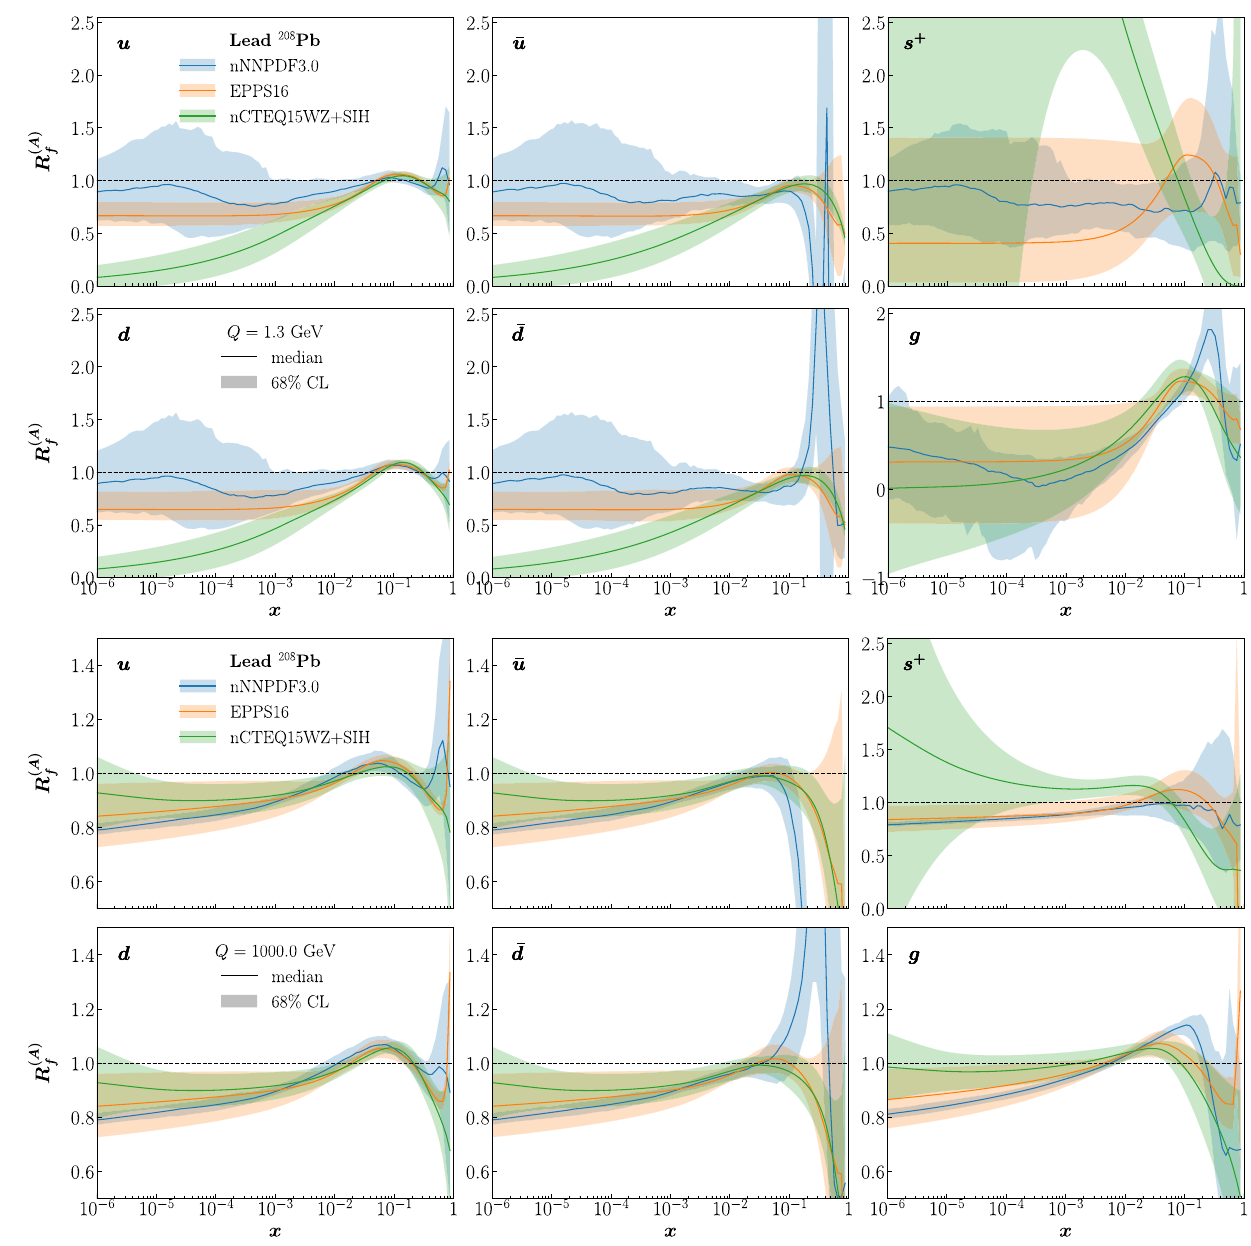
Fig. 19 Same as Fig. 17 now displayed at Q = 1 . 3 GeV (the lowest common scale among the three nPDF sets) and at Q = 1 TeV in the upper and lower panels